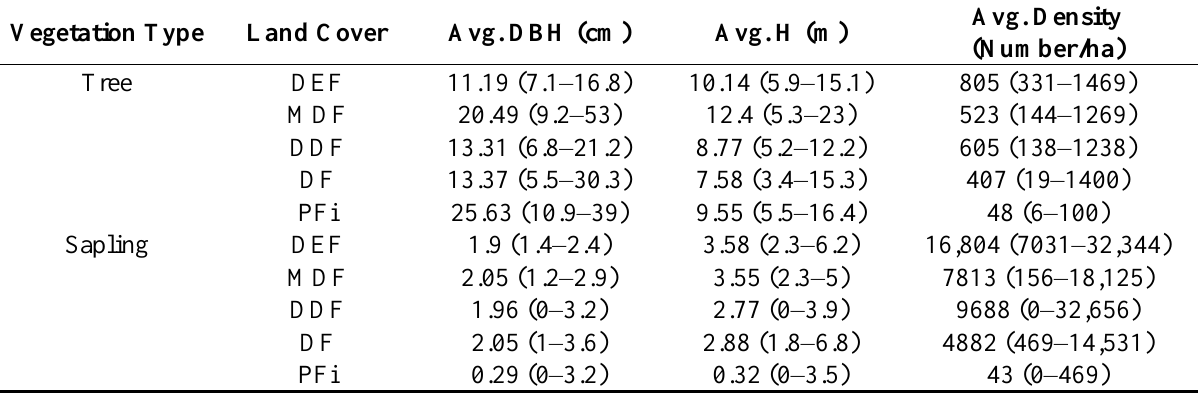
Table 3. Average diameter at breast height (DBH), height (H), and density values of the trees and saplings for each land-cover type.